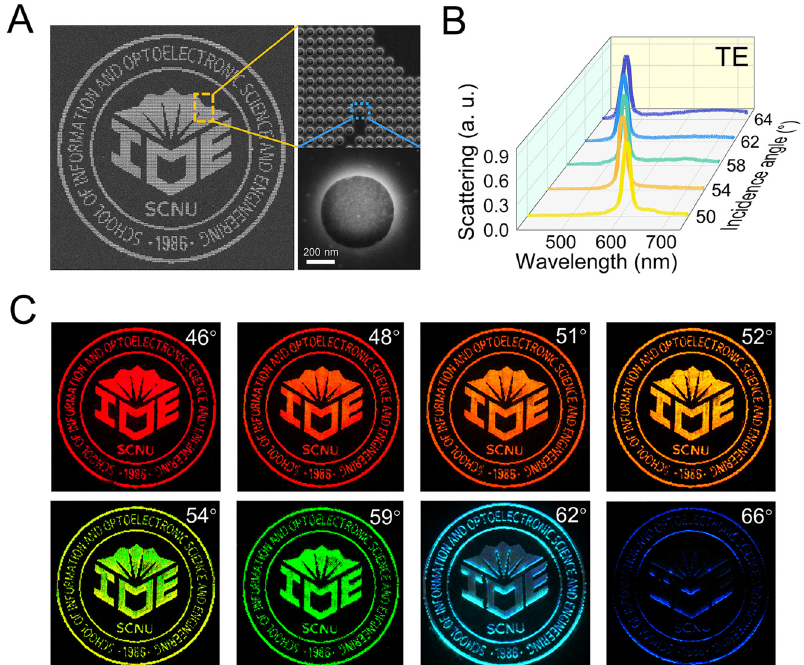
Figure 5: (A) SEM images of the school logo composed of nanoholes dug in the Si 3 N 4 layer. (B) Scattering spectra measured at a nanohole used to scatter the TE wave excited at different incidence angles. (C)